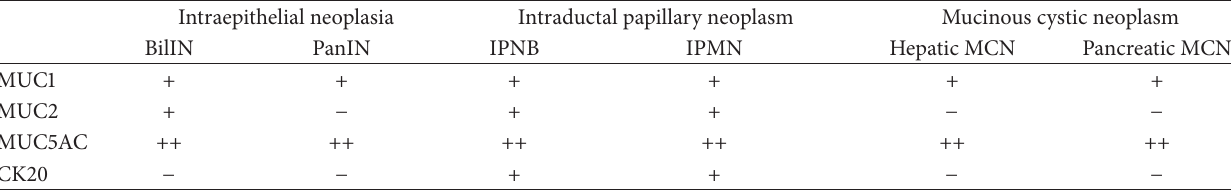
Table 2: Immunoprofiles of premalignant lesions of the biliary tract and pancreas.